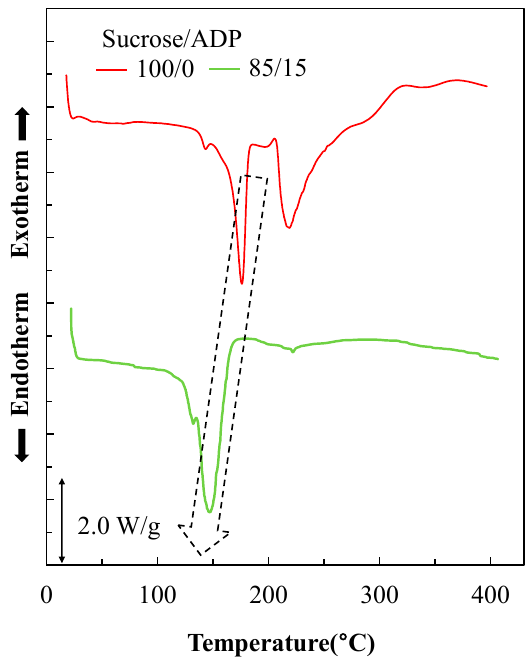
Figure 6. DSC curves of sucrose and SADP 85/15 adhesive.